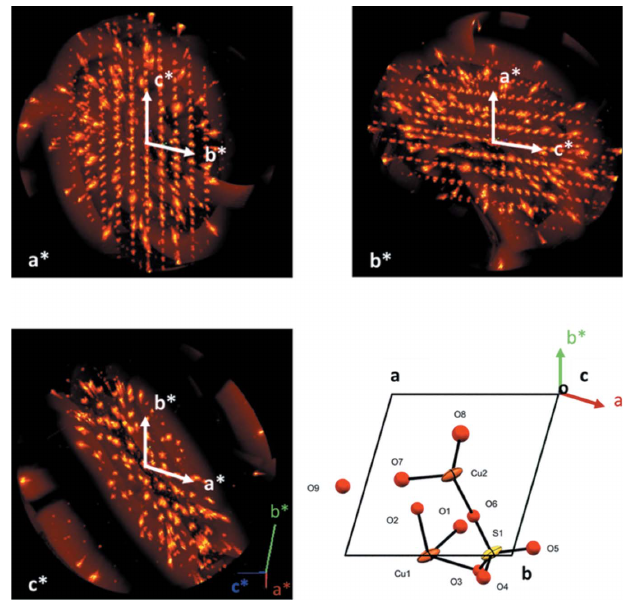
Figure 6 Reconstructed X-ray precession plots viewed along a *, b * and c *. The bright spots exhibiting radial elongation arise from the diamond anvils. The view along the c * axis clearly shows dark areas of reciprocal space due to the shielding of the mini-DAC. A view of the asymmetric unit of copper sulfate pentahydrate along the c axis shows the Cu—O and S—O bonds, with the H atoms removed from the structure for clarity, and helps to identify those bonds which have their projections predominantly in the a * b * plane.